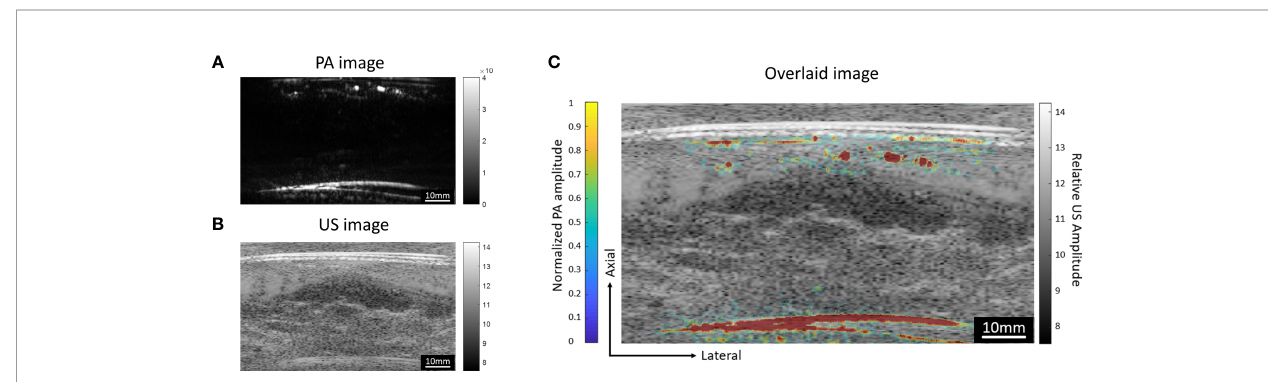
FIGURE 7 | Cross-sectional (A) PA and (B) US images acquired by the top transducer. Both images show the strong interfaces created by the breast surfaces. In the PA image, depth-enhanced weighting was removed to reveal the signals of the breast surfaces. (C) PA image overlaid on the US image. The US image is shown in grayscale, while the PA image is shown in